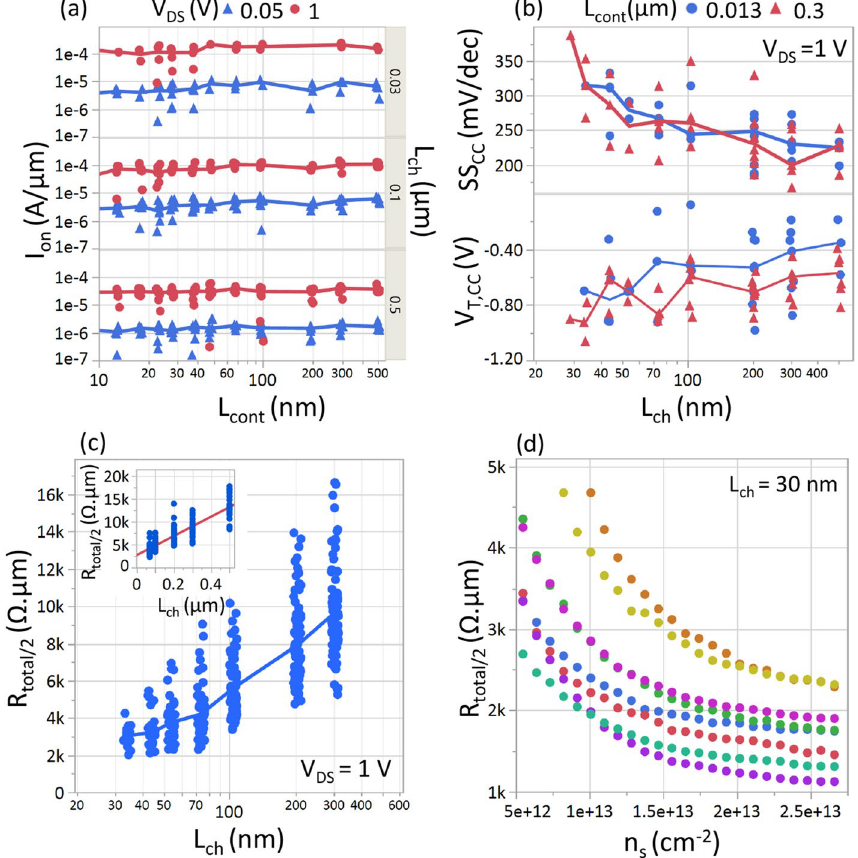
Figure 3. Scatter plot (with median line) of ( a ) I on (at n s = 1e13 cm −2 ) versus L cont for L ch = 30 nm (contact- limited), 100 nm (intermediate regime), and 500 nm (mobility limited). No dependence on L cont down to 13 nm indicates carrier injection from the edge of the metal directly into the MoS 2 channel with L T < 13 nm. ( b ) SS CC and V T,CC versus L ch for L cont = 13 nm and 300 nm. No systematic deviation with L cont indicates identical electrostatics in both cases. ( c ) R total/2 (at n s = 1e13 cm −2 ) versus L ch show saturation below L ch = 50 nm due to contact resistance. Upper limit for R C is obtained as median R total/2 for L ch = 30 nm. Median R C values of 3 kΩ.μm with best performers at 2 kΩ.μm are obtained. (inset) TLM fit of R total/2 (at n s = 1e13cm −2 ) versus L ch gives R c = 2.7 kΩ.μm and field-effect mobility = 15 cm −2 /V.s ( d ) R total/2 versus n s for L ch = 30 nm at V DS = 1 V of 8 devices. R C significantly reduces at n s = 2e13 cm −2 due to better carrier injection into the accumulated